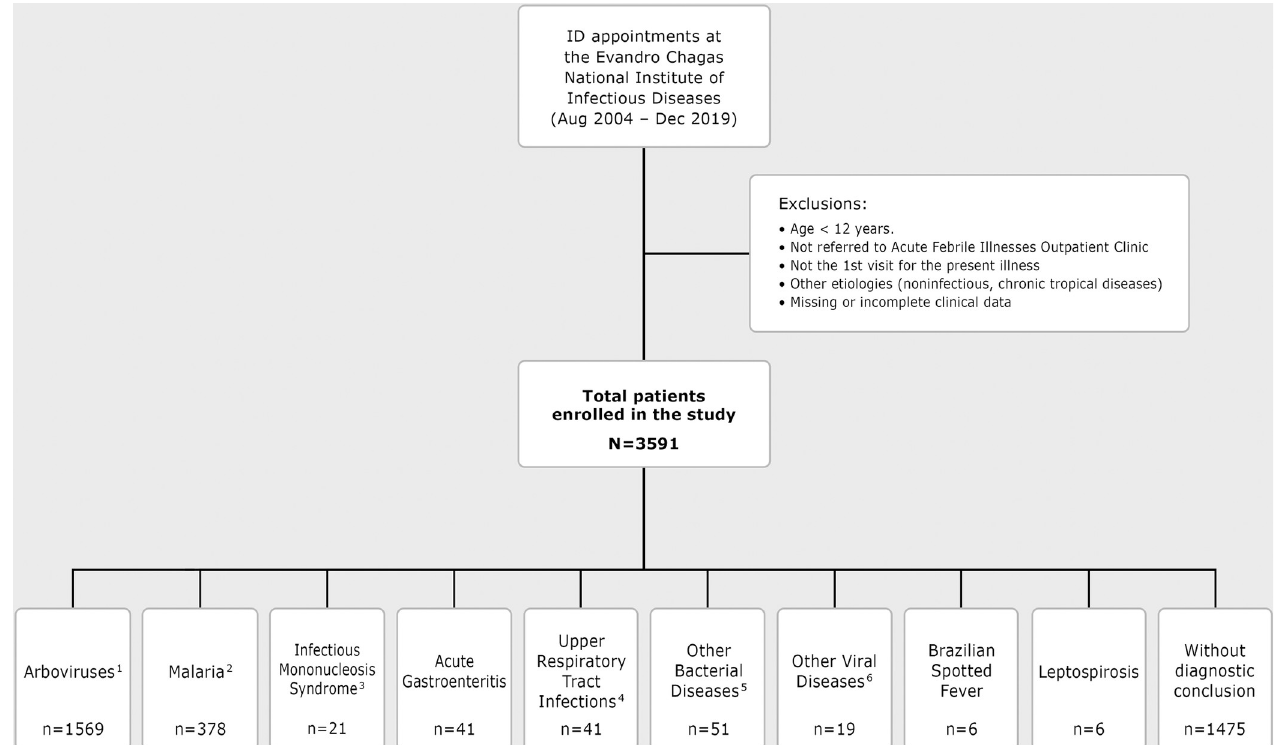
Fig 1. Flowchart with patient enrollment and the acute febrile illness etiologies from August 2004 to December 2019. 1. Laboratory-confirmed dengue (521 patients), zika (227), chikungunya (759), yellow fever (25); co-infections: dengue/zika (1), dengue/chikungunya (12), zika/chikungunya (6), dengue/ malaria (7) and chikungunya/malaria (11). 2. Lab-confirmed P . vivax (248), P . falciparum (97), P . malariae (3), P . ovale (5), mixed ( P . vivax and P . falciparum ) (2); co-infection malaria/dengue (7), co-infection malaria/chikungunya (11), not specified (5). 3. Lab-confirmed acute infection caused by Epstein-Barr Virus (EBV), cytomegalovirus (CMV), HIV or Toxoplasma gondii , resulting in acute infectious mononucleosis syndrome. 4. Includes common cold and acute bacterial rhinosinusitis. 5. Clinical or lab-confirmed bacterial pneumonia (15), bacterial pharyngitis/tonsillitis (11), secondary syphilis (9), urinary tract infection (7), tuberculosis (3), typhoid fever and sepsis (2), cholecystitis (3) and brucellosis (1). 6. Acute viral hepatitis (A and B) (11), parvovirus B19 (3), Varicella-Zoster infection (including chickenpox) (4), nonspecific viral meningitis (1).